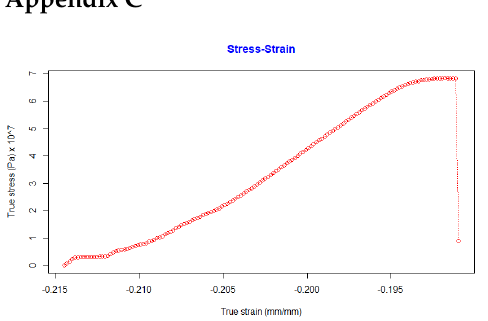
Figure A1. Strain–stress for tensile